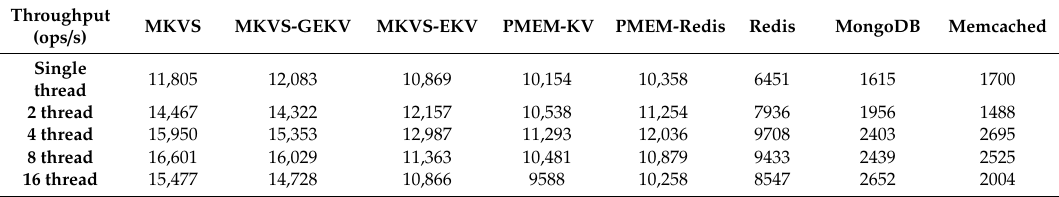
Table 4. The results of multithreads with